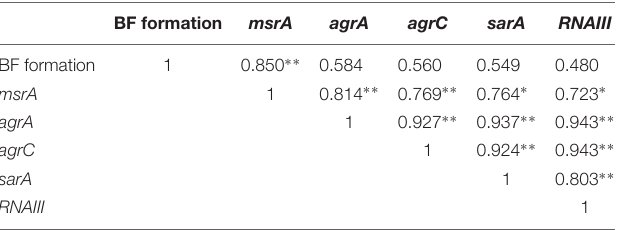
TABLE 2 | Pearson’s correlation coefficients between the relative expression of msrA and biofilm formation ability and the expression of agr system-associated